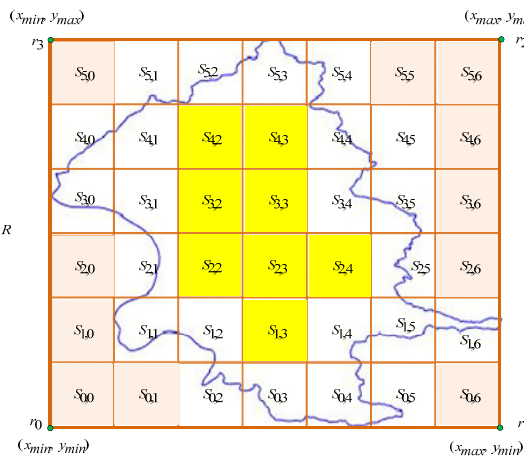
Figure 6. Partitioning a rectangle into a set of squares.